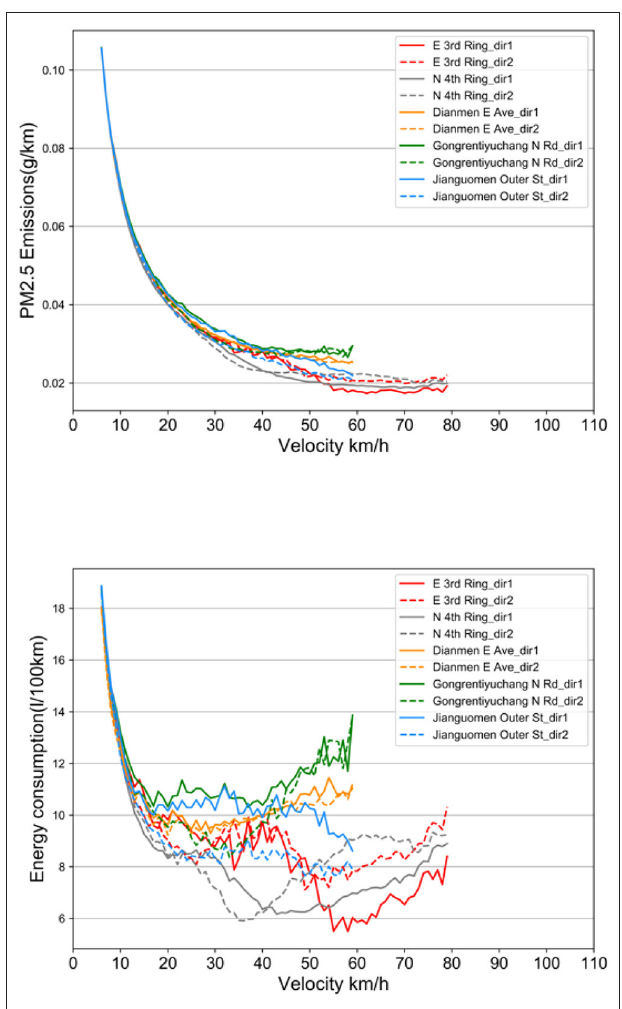
FIGURE 10 | Relationship between PM2.5 emissions and energy consumption at different